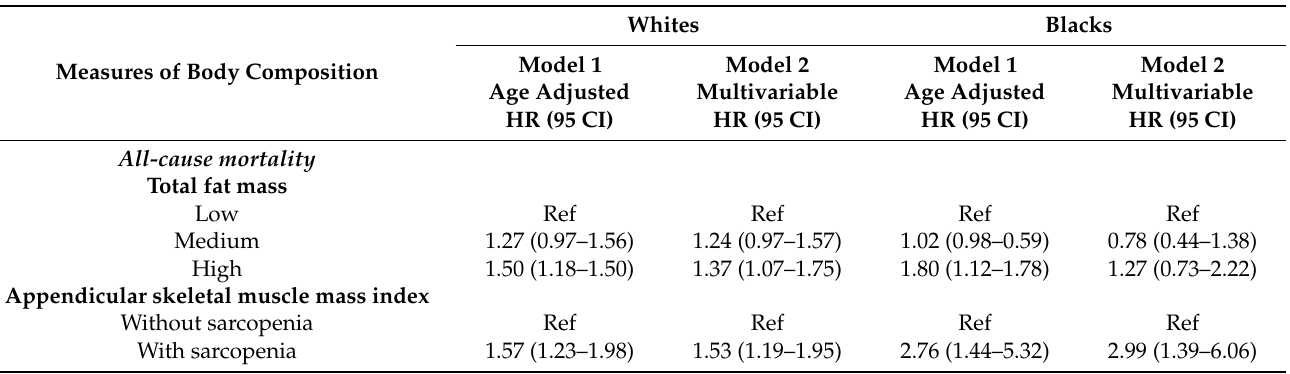
Table 4. Associations between DXA measures between total fat mass and sarcopenia with risk of all-cause mortality in cancer survivors by